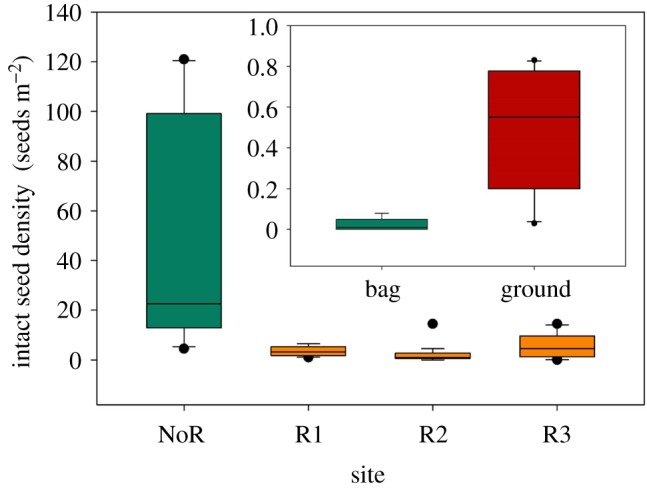
Differences in intact seed density among the four study areas. R1 (N = 20), R2 (N = 20) and R3 (N = 10): three sites with human collection; NoR: site without human collection (N = 10). N = number of trees sampled in each site. Inset: box plot showing partially eaten seed proportion (eaten/intact seed pools) measured on the ground under Araucaria araucana trees subject to human collection and inside gatherers' bags. Both box plots show median values (central horizontal lines), 25th and 75th percentile regions around the median value (box limits), 10th and 90th percentiles (whiskers) and outliers (circles).